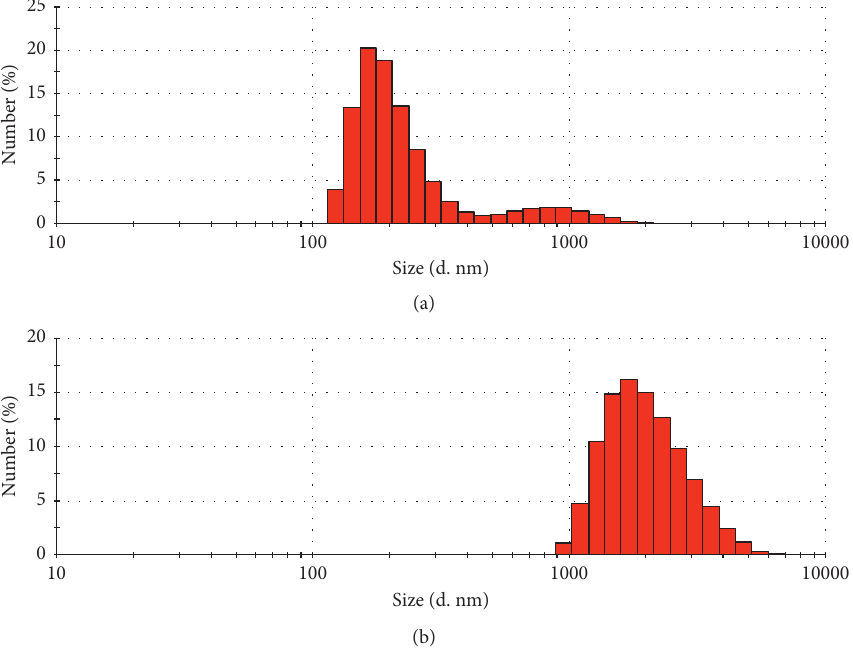
Figure 2: Size distribution plot by Number percentage of nanoCaCO water.